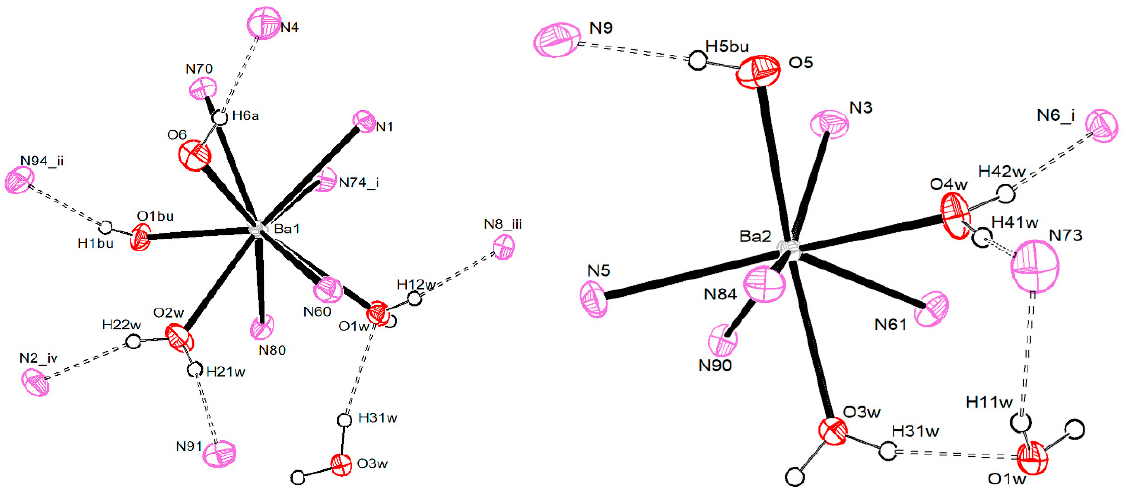
Figure 27 . The first and second coordination spheres of Ba1 and Ba2.